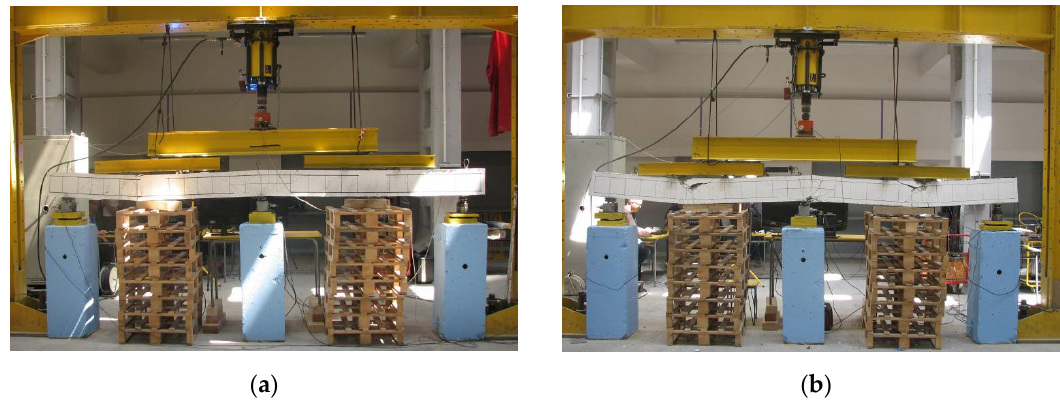
Figure 18. Beams at the time of failure: ( a ) Beam No. 1, ( b ) Beam No. 2.